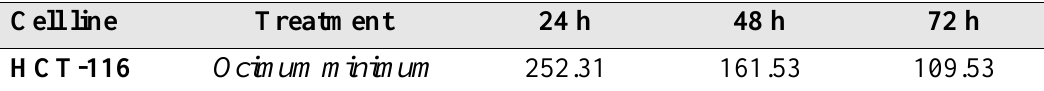
Table 1. Cytotoxic effects of O. minimum expressed as IC on HCT-116 colorectal cancer cell line.